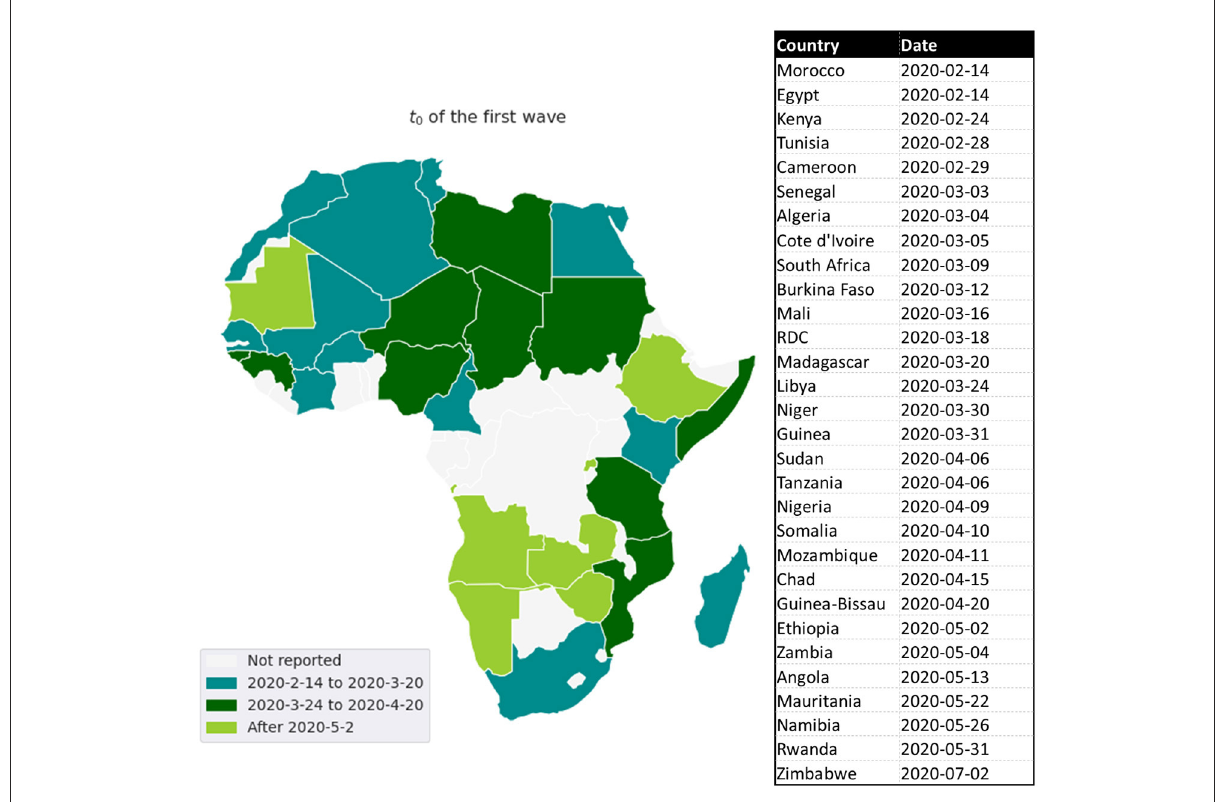
FIGURE6 Distribution of the t 0 for the first